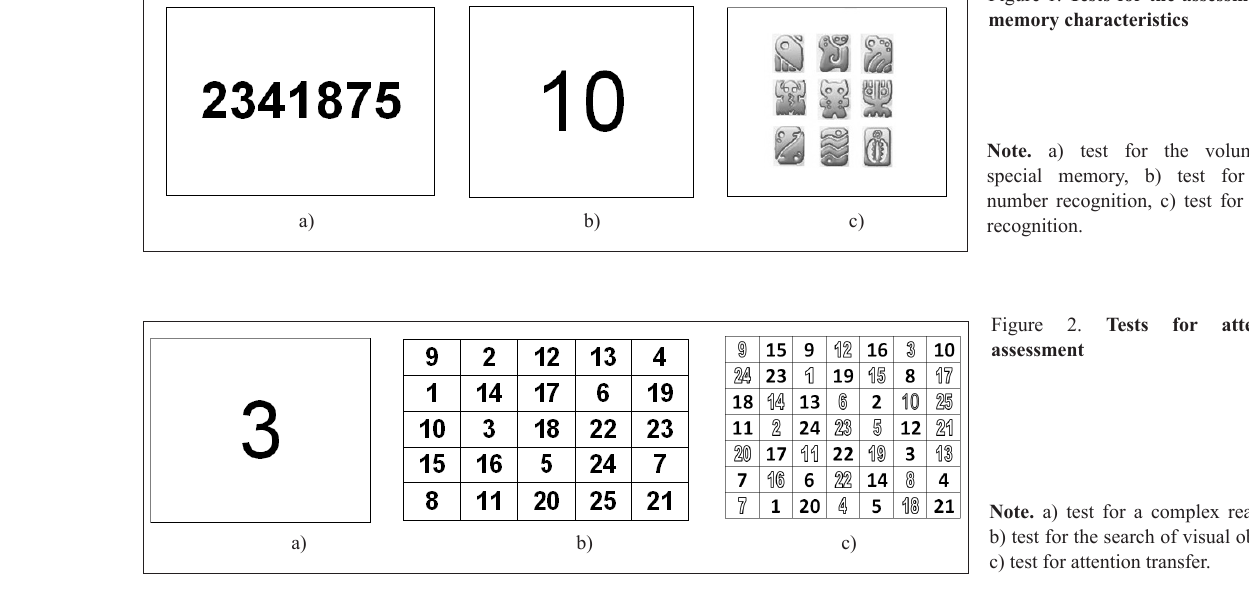
Figure 1. Tests for the assessment of memory characteristics